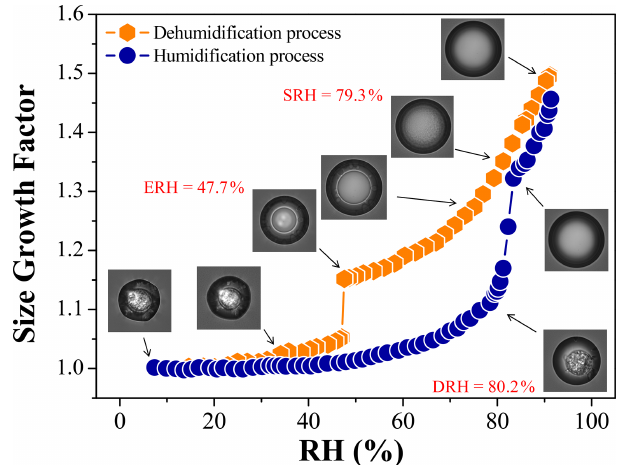
Figure 1. Hygroscopic cycle of the mixed 1, 2, 6-hexanetriol / AS particle with OIR = 1 : 1. The panels show the optical images cor- responding to the GFs at a particular RH. The SRH, ERH and DRH values are given in